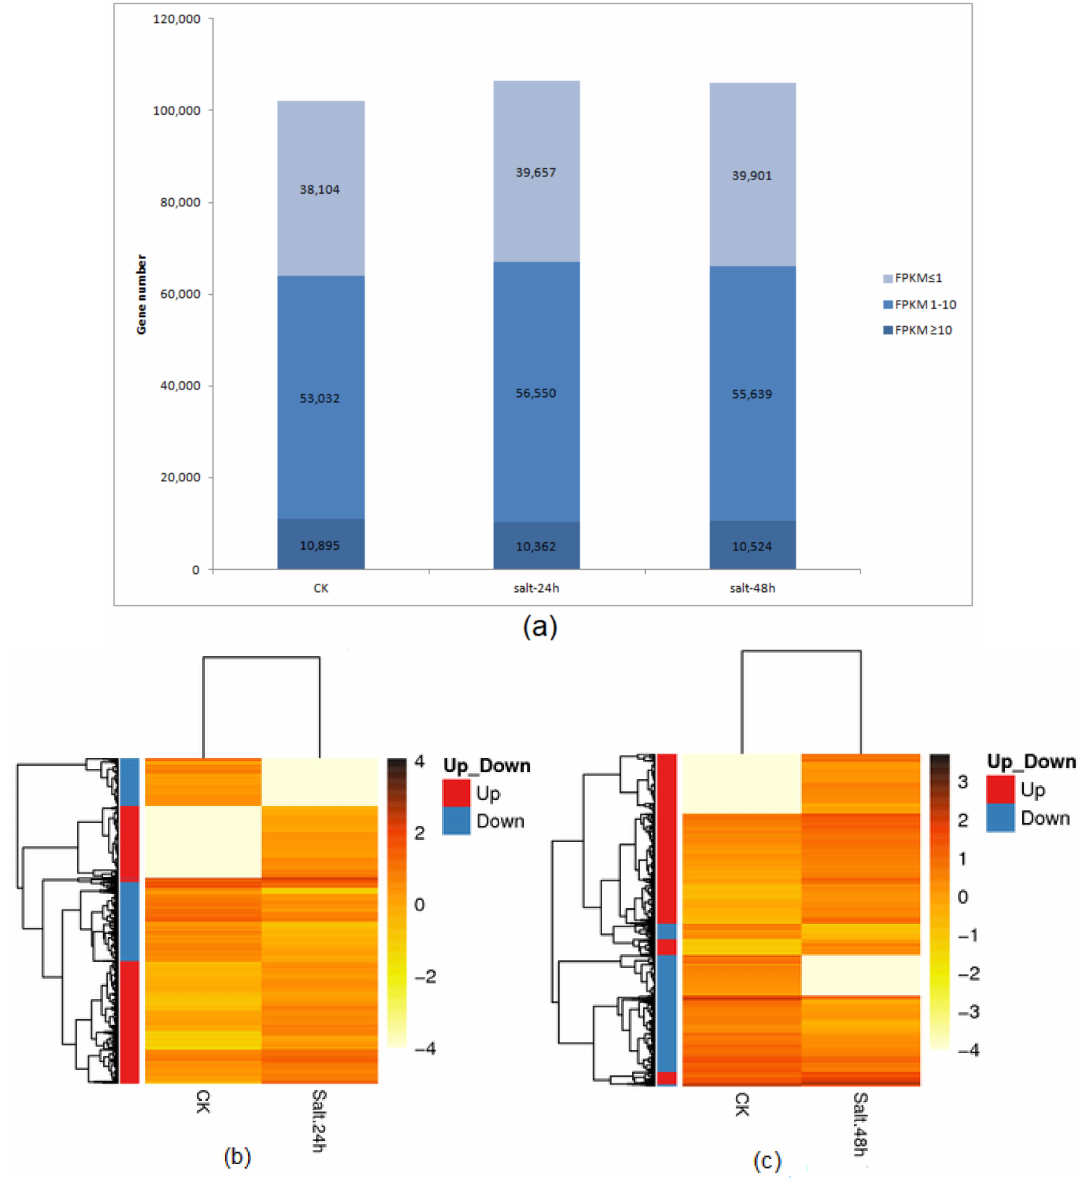
Figure 5. Plots of differentially expressed genes (DEGs) based on ( a ) gene abundance in samples as a function of expression levels in different fragment per kilobase million (FPKM) intervals. The X-axis represents the sample name, the Y-axis represents the number of genes, and the shade of color represents the level of different expression levels: FPKM ≤ 1 is when a gene has a very low expression level, FPKM is between 1 and 10 (when genes have low expression levels), and FPKM ≥ 10 are genes with high expression levels. ( b , c ) A heat map showing differential gene expression; the X-axis represents different samples and the Y-axis represents the differential gene. The darker the color, the higher the expression, while the lighter the color, the lower the